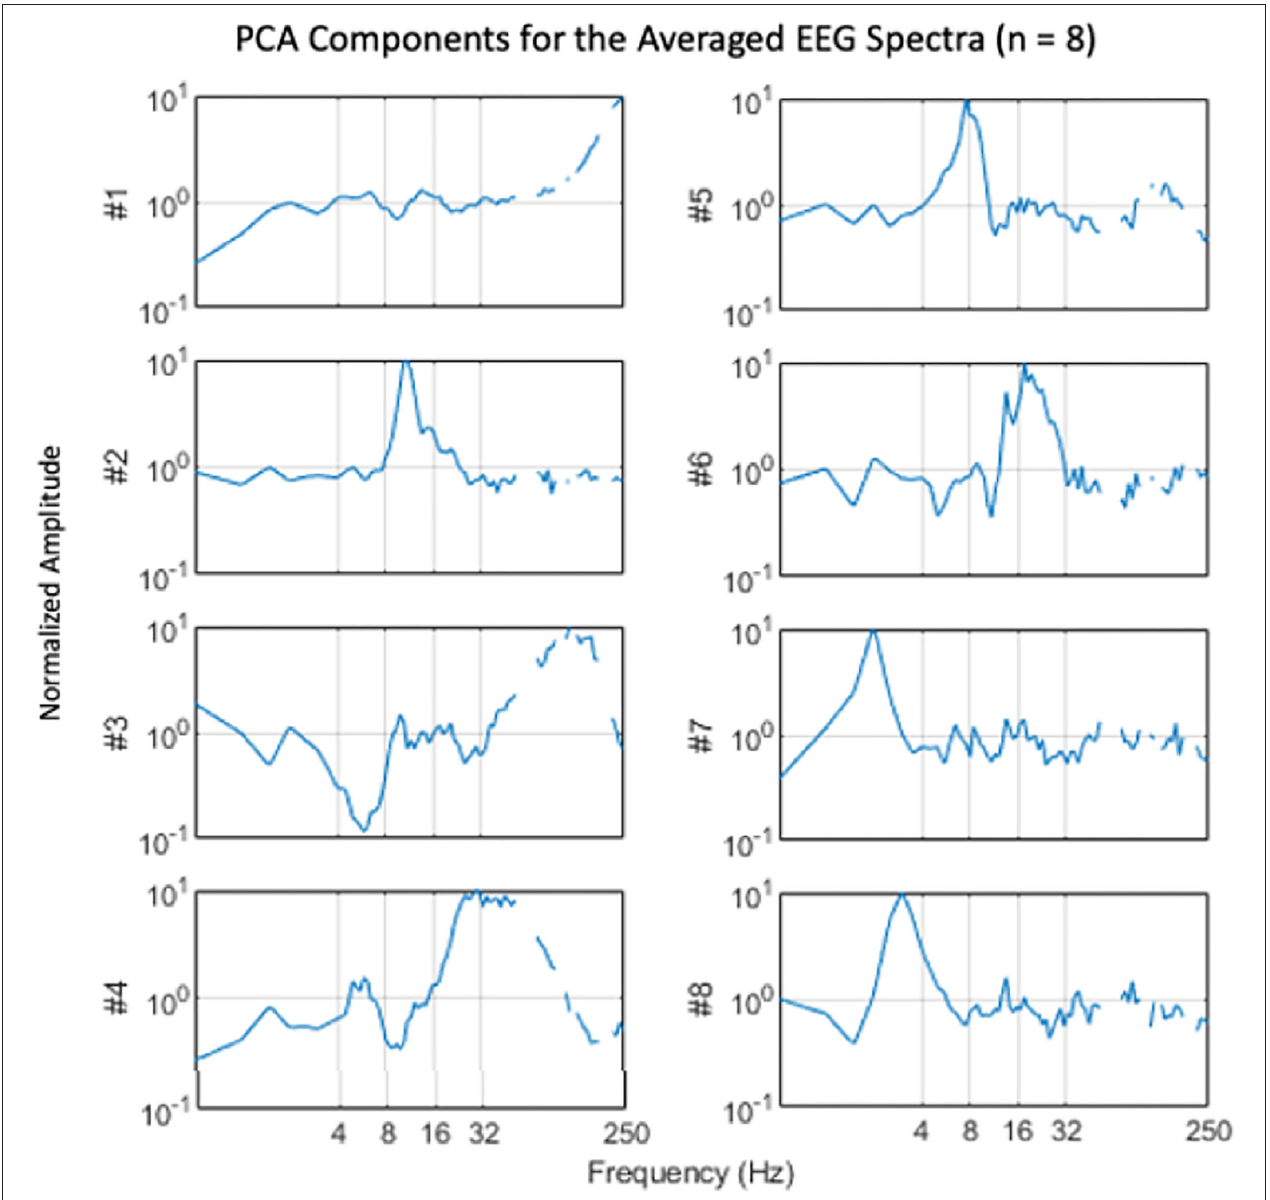
FIGURE 4 | Average spectral components derived by principal components analysis. Note the tendency for components to be focused on narrow frequency bands at 2 (#7), 3 (#8), 8 (#5), 11 (#2), 18 (#6), 25–40 (#4), and 120–160 (#3) Hz (Gaps at higher frequencies are spectral regions excluded from analysis due to electrical